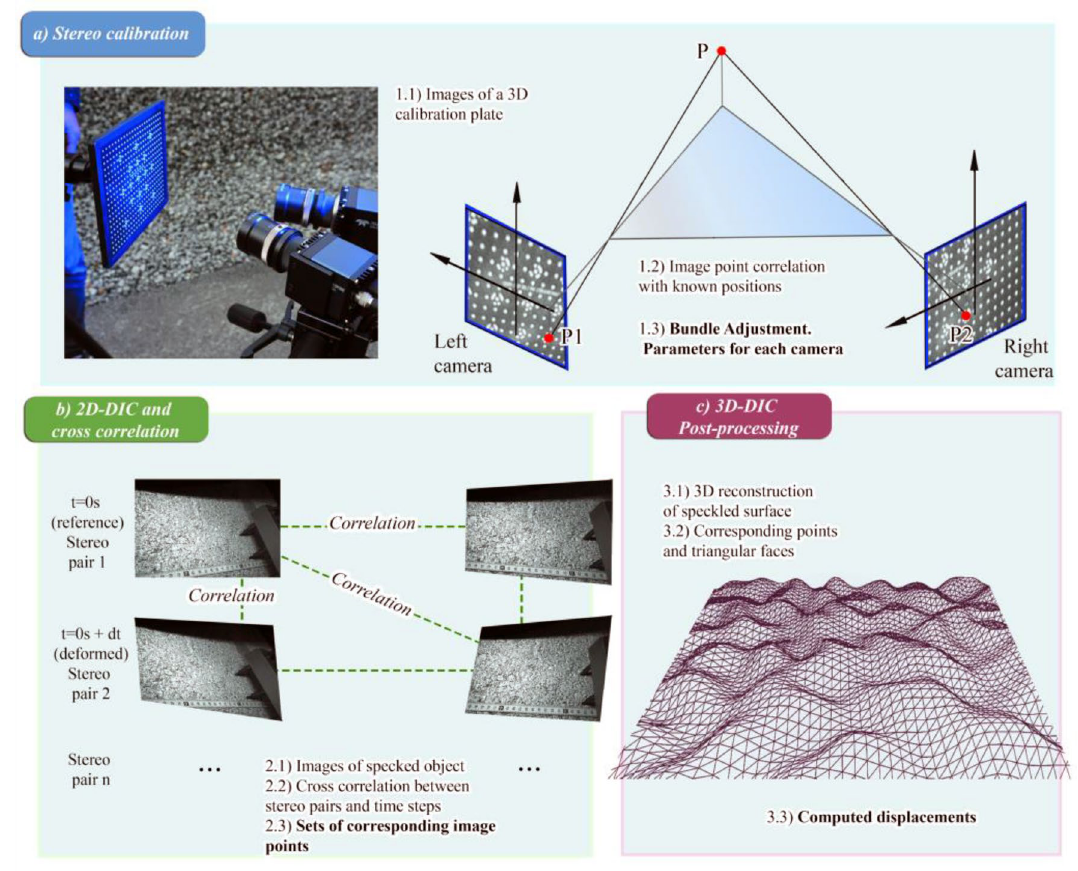
Figure 2. Workflow with the core steps in stereo-DIC processing: ( a ) Stereo calibration procedure to find intrinsic and extrinsic parameters of the optical system; ( b ) cross-correlated 2D-DIC and ( c ) 3D-DIC post- processing to calculate 3D coordinates of the triangular mesh’s vertices and to derive the full-field displacements. Adapted from Arza et al. 82